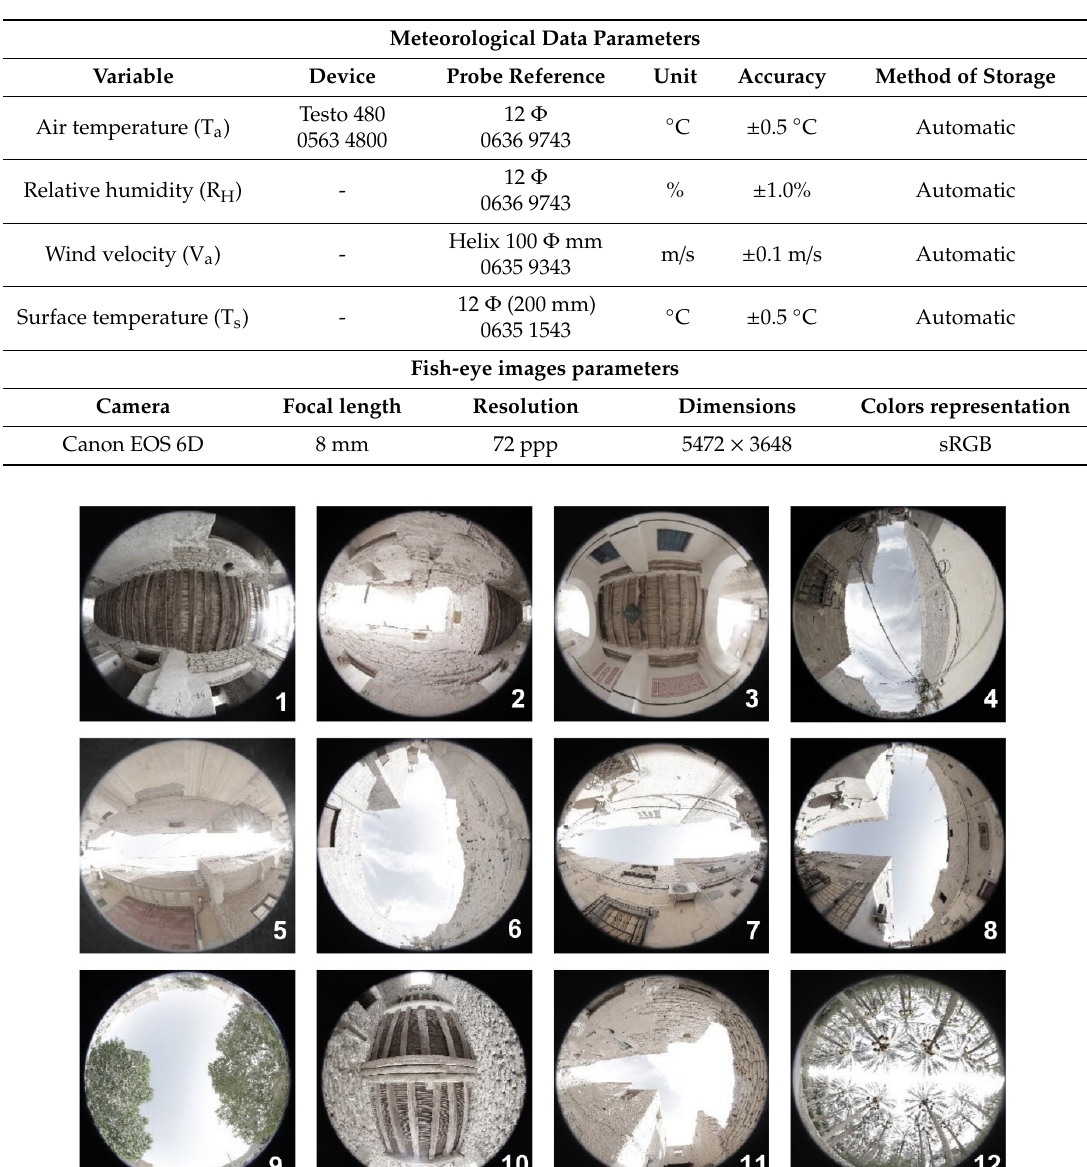
Table 2. Instruments used for the data measurement.